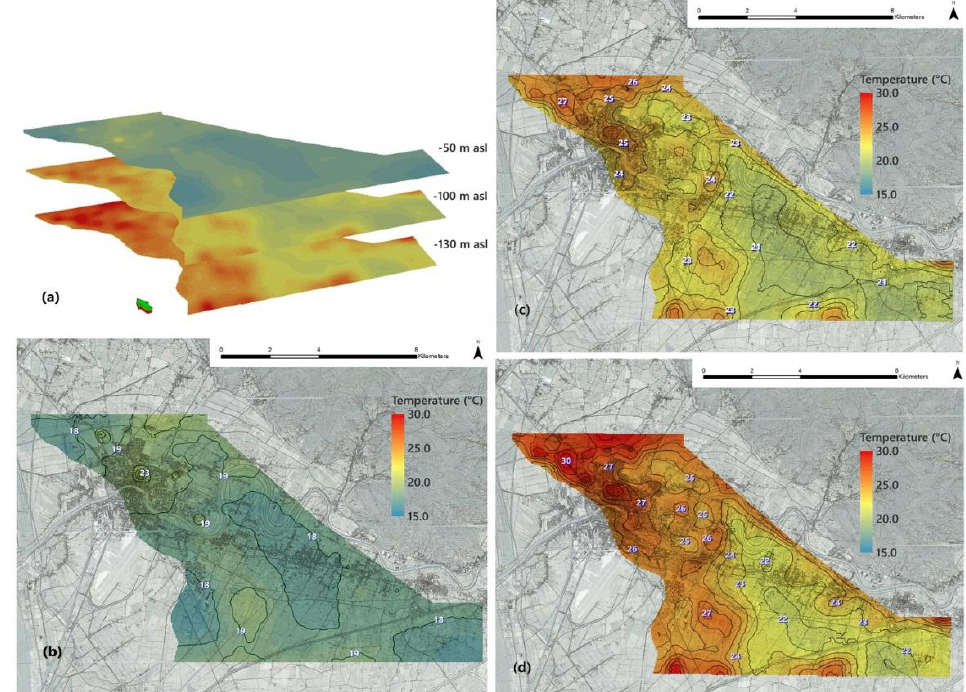
Figure 12. Maps of isotemperatures obtained using IDW interpolation of 3D point cloud of temperature, see Figure 10. ( a ) 3D visualization. ( b ) 2D visualization at −50 m a.s.l. ( c ) 2D visualization at −100 m a.s.l. ( d ) 2D visualization at −130 m a.s.l. In ( b – d ), isotemperature contours are also shown.